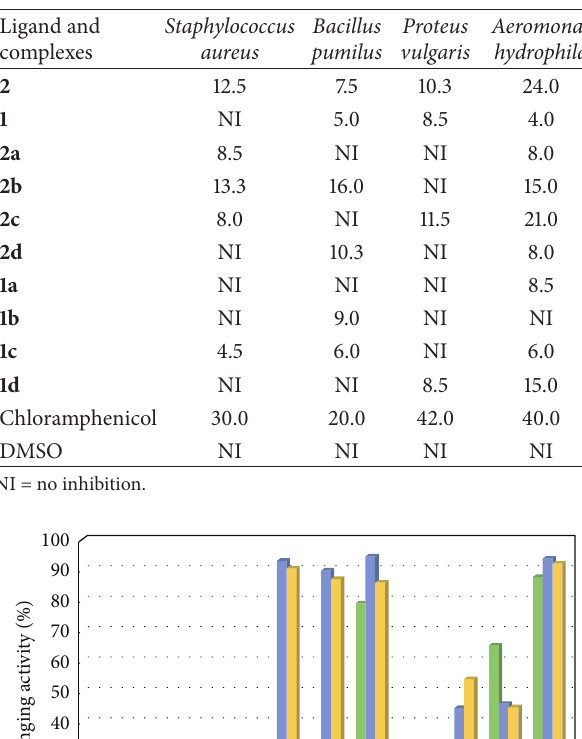
Table2:ZoneofgrowthinhibitionexhibitedbysulfanilamideSchiff bases and metal complexes at 40mg/mL (mm).